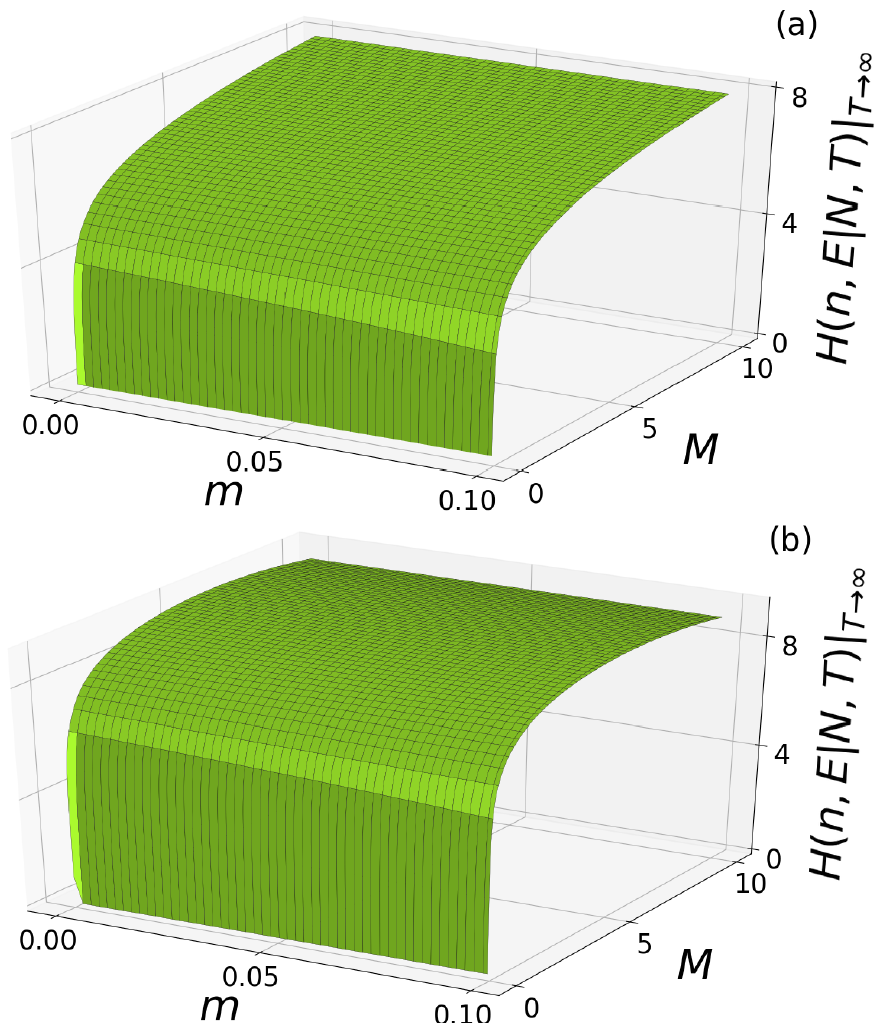
Figure 5. (Color online) The same as Figure 4 but for bosons with ( a ) N = 100 and ( b ) N = 1000 par- ticles in the